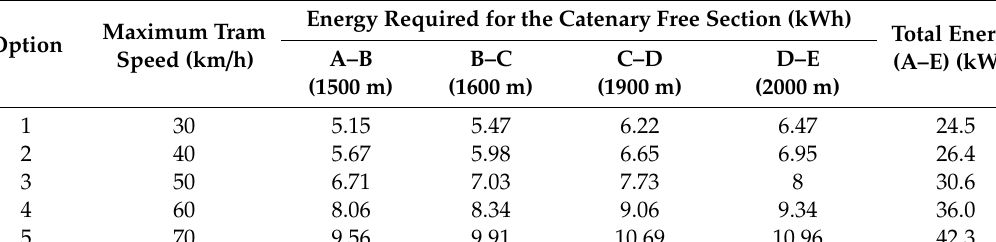
Table 4. Simulation results for the catenary free section.